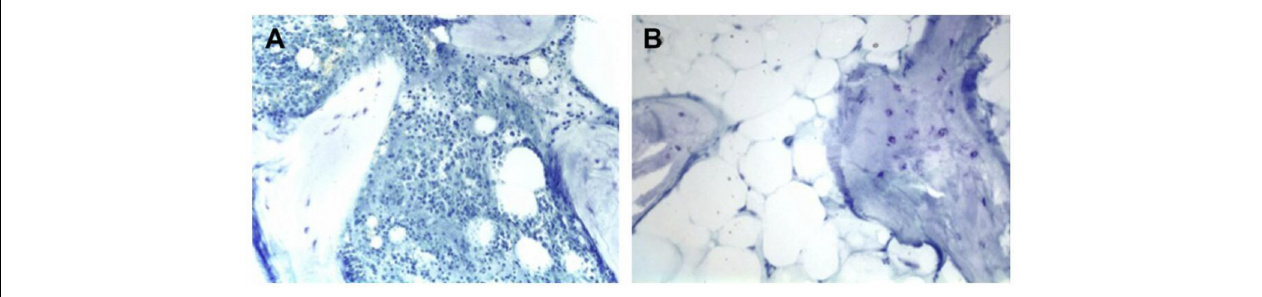
FIGURE 1 | Histologic slides of iliac (A) and tibial (B) bone graft. The iliac crest bone graft shows abundant osteoblasts and hematopoietic marrow. The tibial bone graft shows fatty marrow without hematopoiesis. Reproduced from Chiodo et al. (2010) with permission from SAGE (Copyright